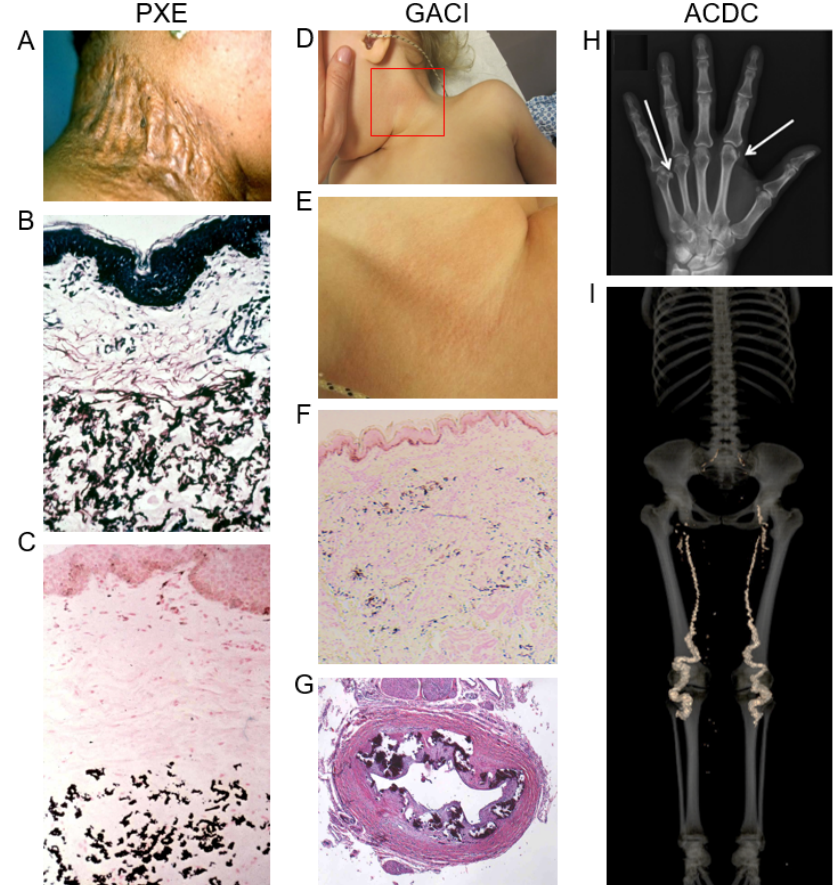
Figure 1. Clinical features and ectopic mineralization in pseudoxanthoma elasticum (PXE), gen- eralized arterial calcification of infancy (GACI), and arterial calcification due to CD73 deficiency (ACDC). PXE is characterized by late-onset cutaneous manifestations, including loose and inelastic skin ( A ). Biopsy of the affected area of skin reveals accumulation of pleomorphic elastotic material in mid dermis as visualized by Verhoeff-van Gieson stain ( B ). The aberrant elastotic material demonstrates calcification, as shown by von Kossa stain ( C ). Some patients with GACI manifest with early cutaneous findings similar to PXE ( D ; boxed area in D is enlarged in E ), and histopathology reveals evidence of ectopic mineralization of skin elastic fibers in the dermis ( F ). In classic cases of GACI, the patients demonstrate severe vascular mineralization with intimal hypo- plasia ( G ), and the patients often die during the early postnatal period. ACDC affects primarily elderly individuals with periarticular calcification ( H , arrows), and extensive vascular calcification in the lower extremities ( I ). (The figures were adopted, with permission, from the following publi- cations: [2–4]. Table 1. Clinical and genetic features of PXE, GACI, and ACDC.